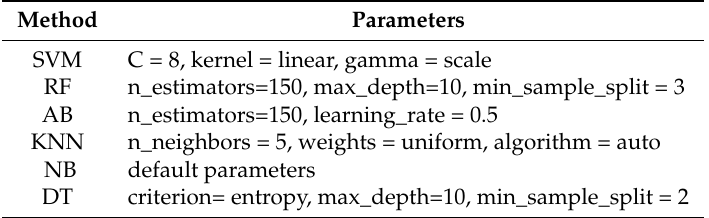
Table 2. Used hyperparameters for the tested classification methods—support vector machines (SVM), K-nearest neighbours (KNN), naive Bayes (NB), decision trees (DT), random forests (RF) and AdaBoost (AB).